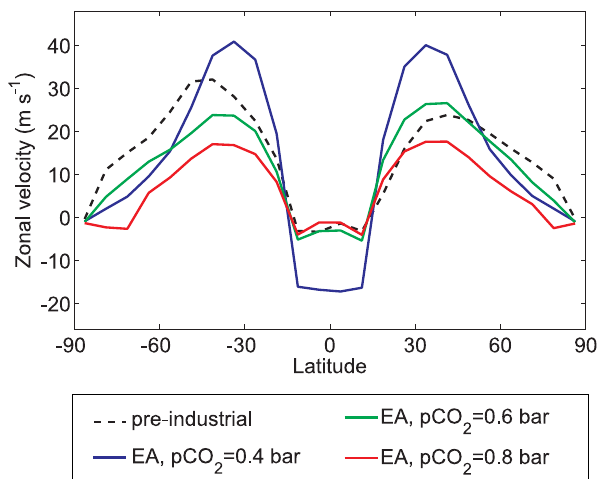
Fig. 11. Maxima of the atmospheric meridional stream functions for the pre-industrial state (black) and the three states of the early Archean (EA).